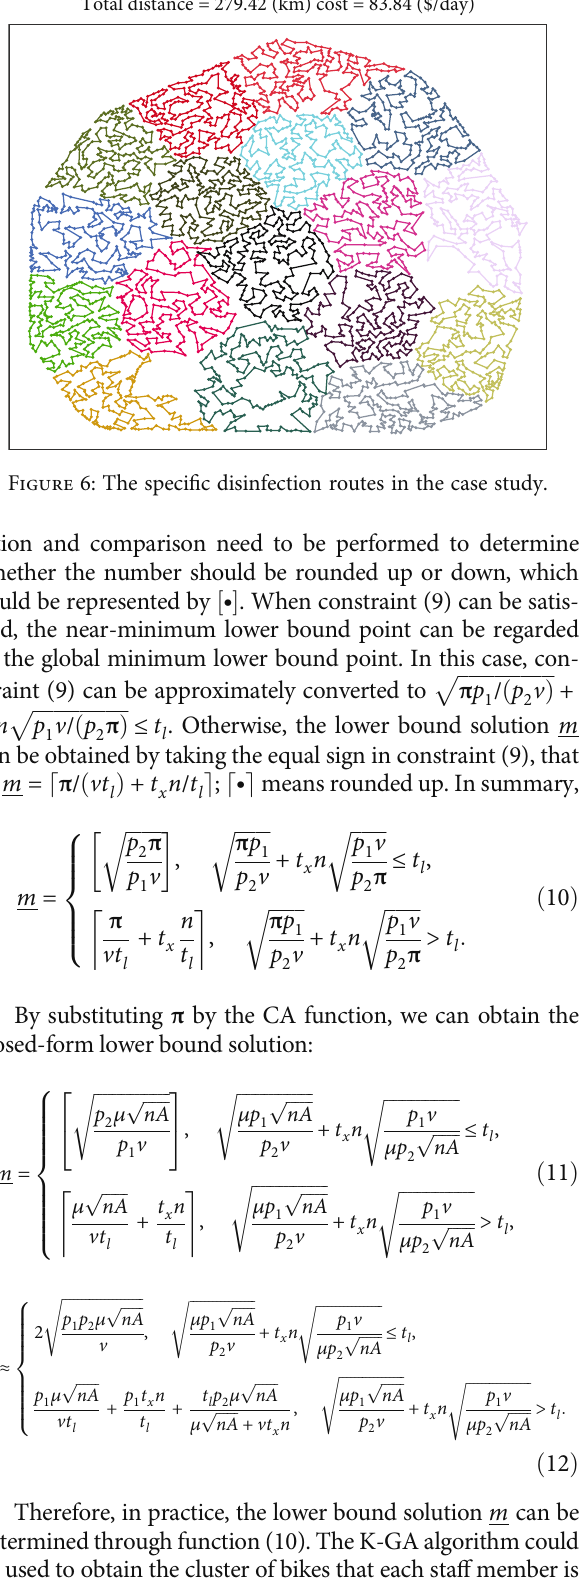
Table 2: The solution of the case study.